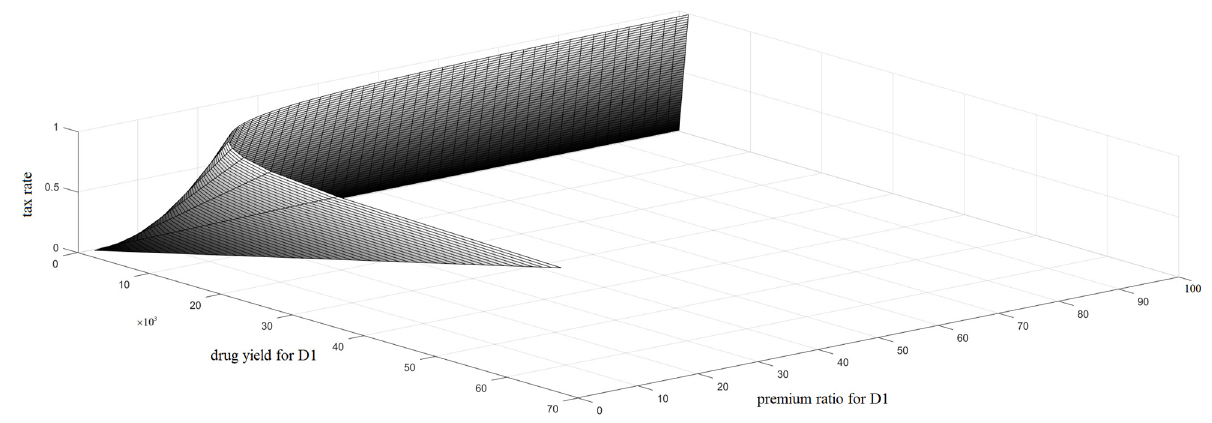
Figure 2. Relationships among tax rate and drug yield for D1 and the premium ratio for D1.